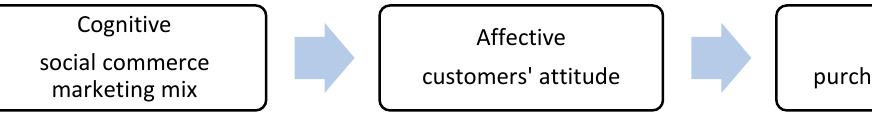
Figure 1. Simple Model based on Cognitive, Affective, Conative